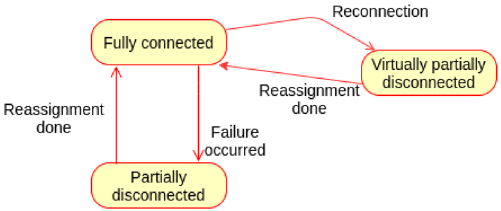
Figure 13. Behaviour of connectivity monitoring and failure